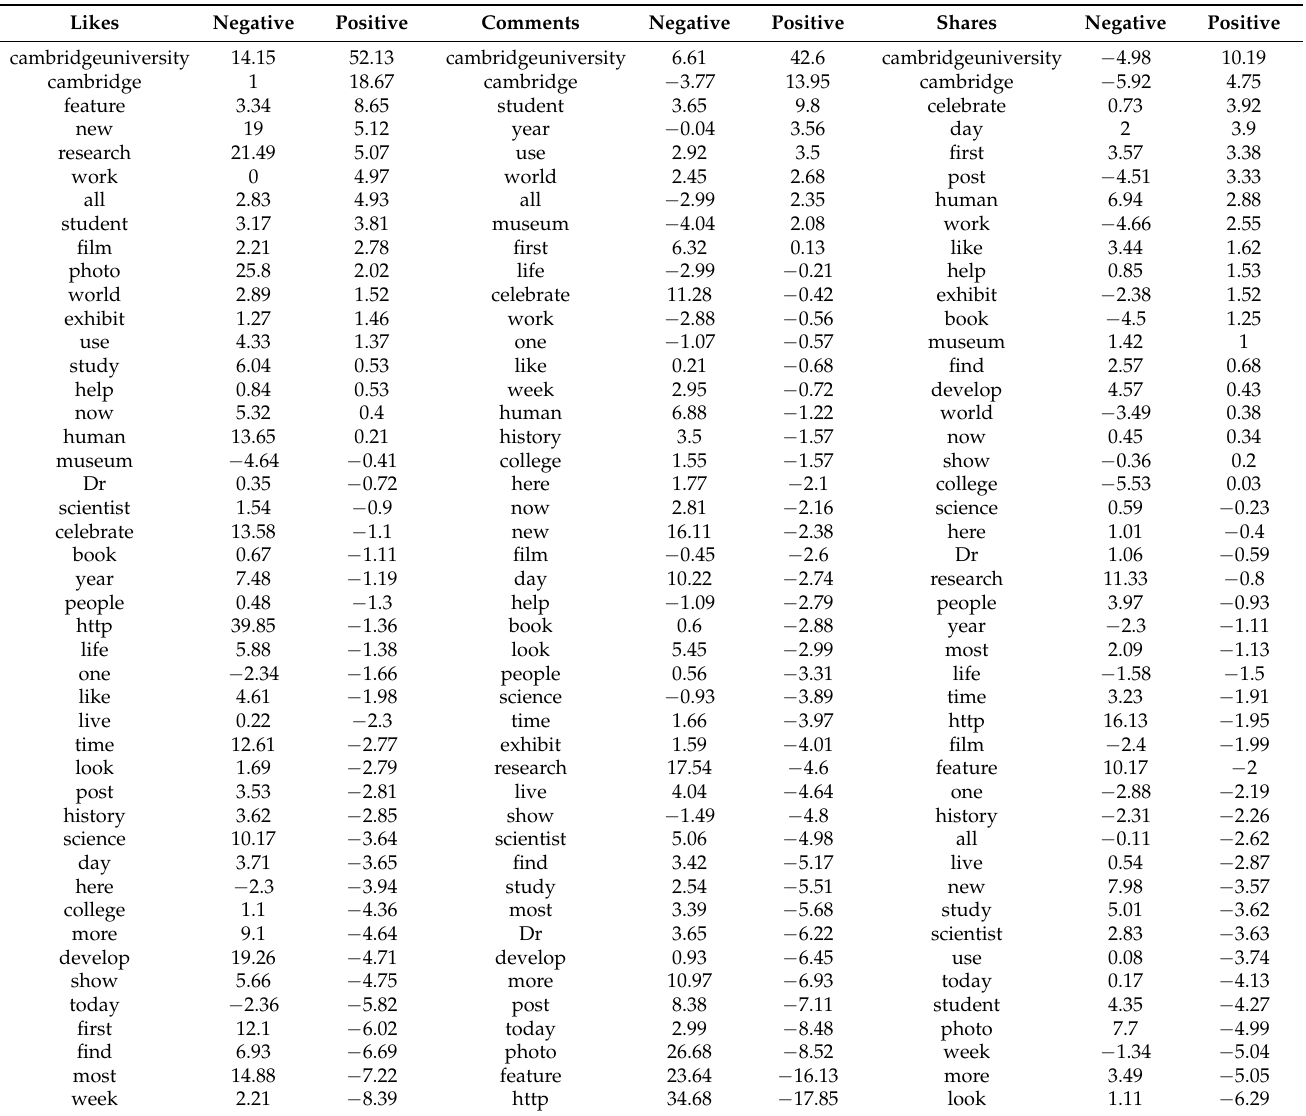
Table A5. Negative and positive clues (University of